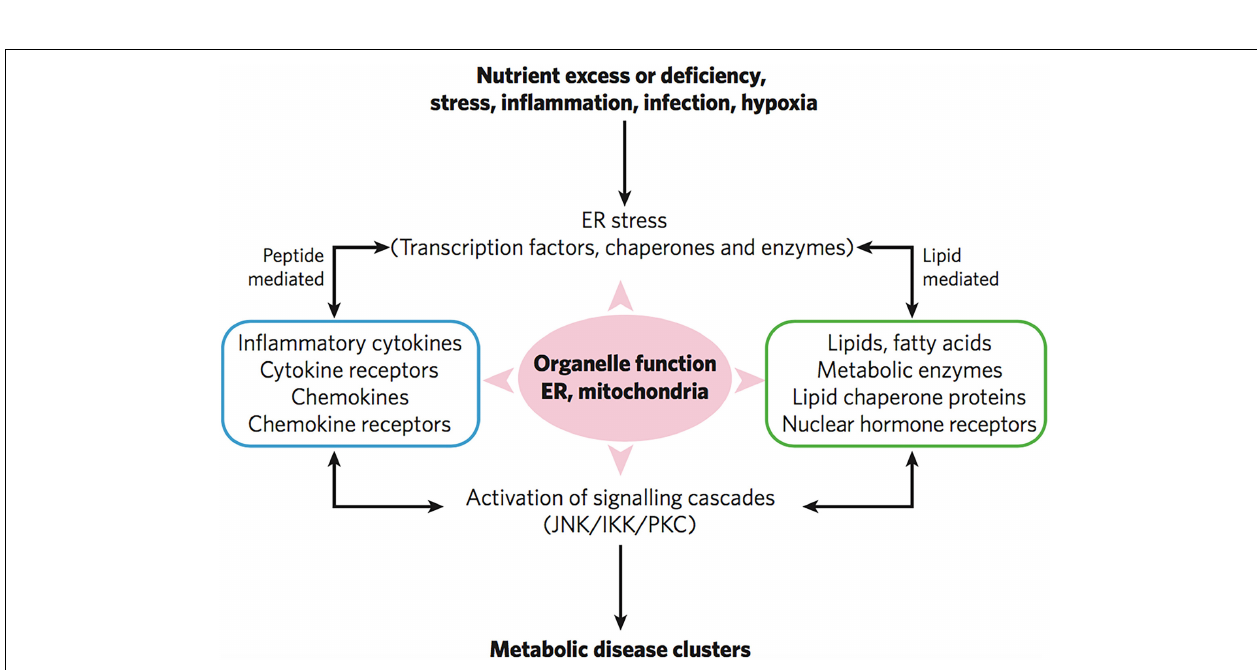
FIGURE 9 | Severe infections trigger inflammatory responses, ER stress and mitochondrial organelle dysfunction through lipid-mediated and cytokine peptide-mediated mechanisms. Reprinted from Hotamisligil (2006) with permission.